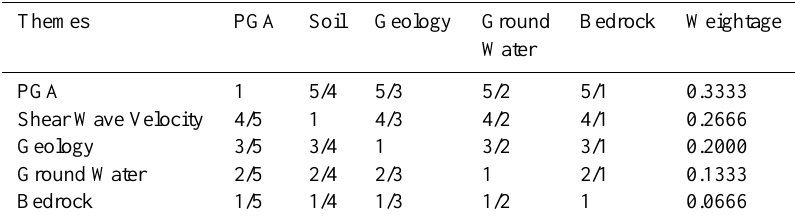
Table 3. Assigned weights for the thematic maps for GIS integration.